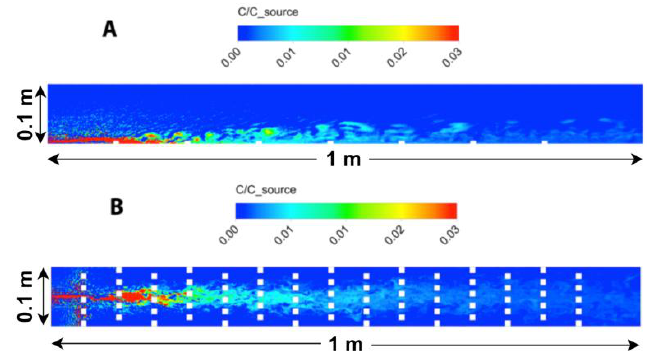
Figure 7. Comparison of horizontal turbulence intensity within the flume experiments and numerical model. Measurements were obtained at 1 m downstream from the source.